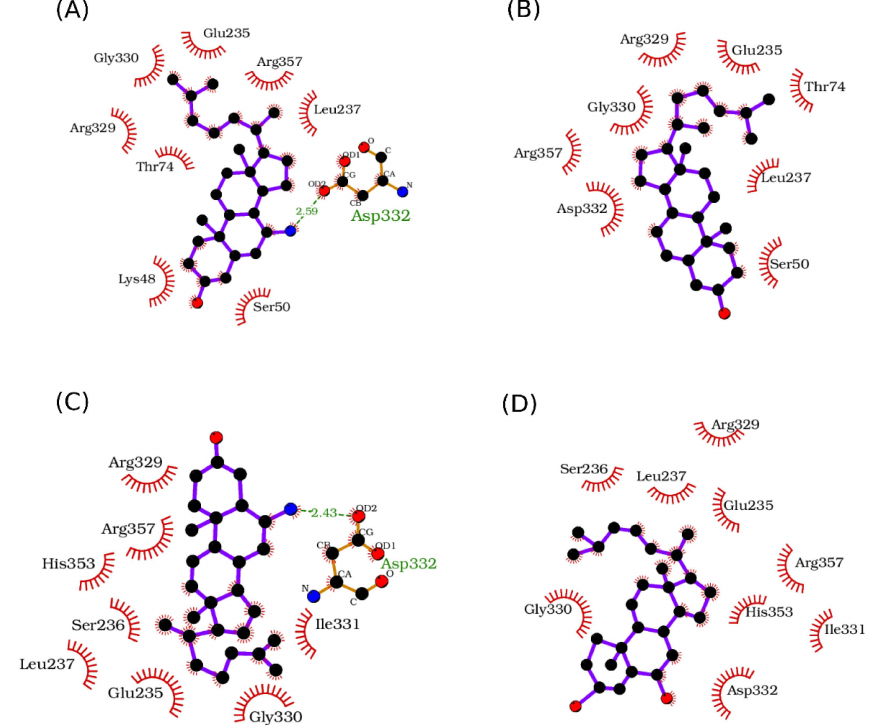
Figure 6. Protein-inhibitor interaction diagrams as determined with LigPlot+. Residues involved in hydrophobic interactions are shown as red half-circles, and H-bonds are shown in green dotted lines along with their lengths in Angstroms. ( A ) Diagram of interaction between LieIF4A and 7- α -aminocholesterol. ( B ) Diagram of interaction between LieIF4A and cholesterol. ( C ) Diagram of interaction between LieIF4A and 6- α -aminocholestanol. ( D ) Diagram of interaction between LieIF4A and